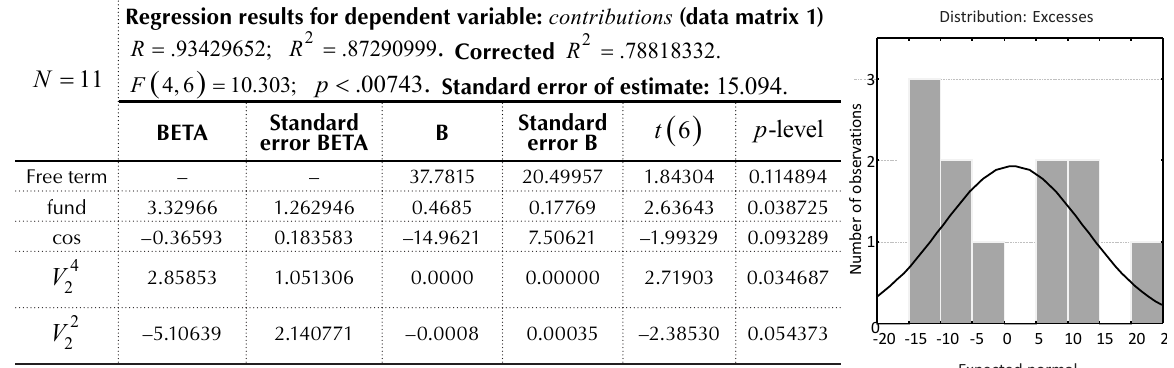
Table 3b. The results of regression for contributions from the members of Investor Compensation Fund (Czech Republic) contributions regression